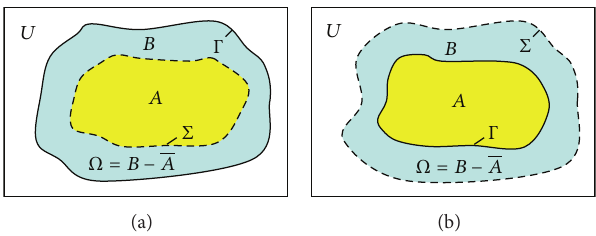
Figure 1: The domain Ω for the interior Bernoulli problem (a) and exterior problem